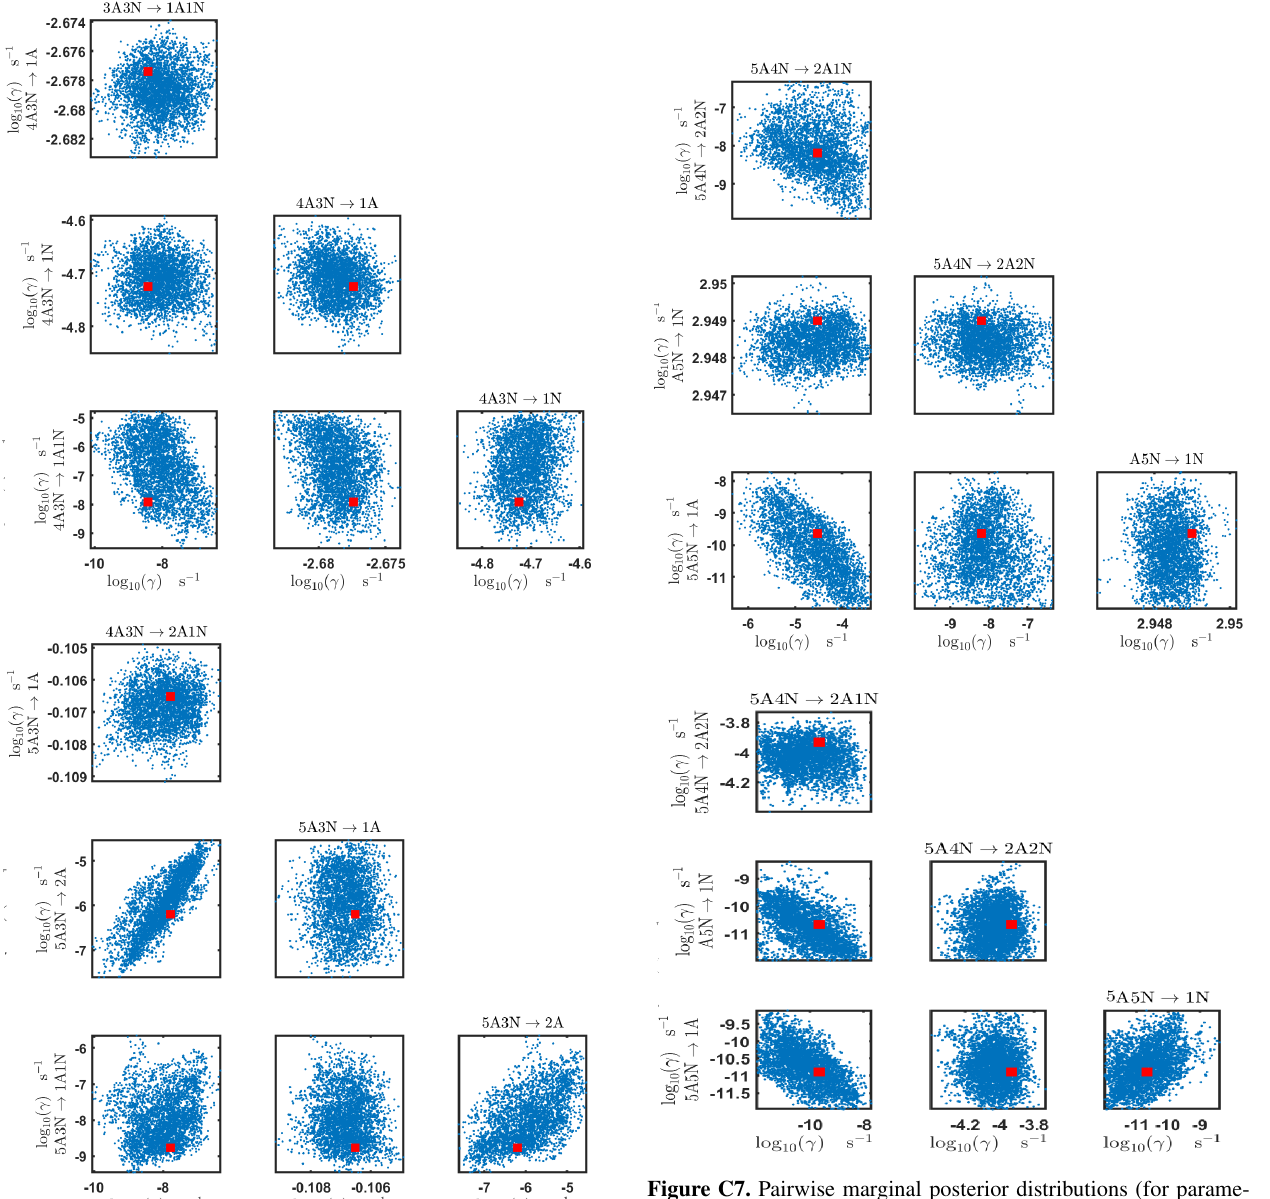
Figure C7. Pairwise marginal posterior distributions (for parame- ter indexes ranging from 25 to 32) of the base 10 logarithm of the evaporation rates (units given in s − 1 ) from time-dependent mea- surements of the cluster concentrations with time resolution com- prising 1.5min at the temperature 278K. Red rectangles denote the baseline values from Olenius et al. (2013b) used to generate the synthetic data. The notation xAyN corresponds to a cluster with x sulfuric acid and y ammonia